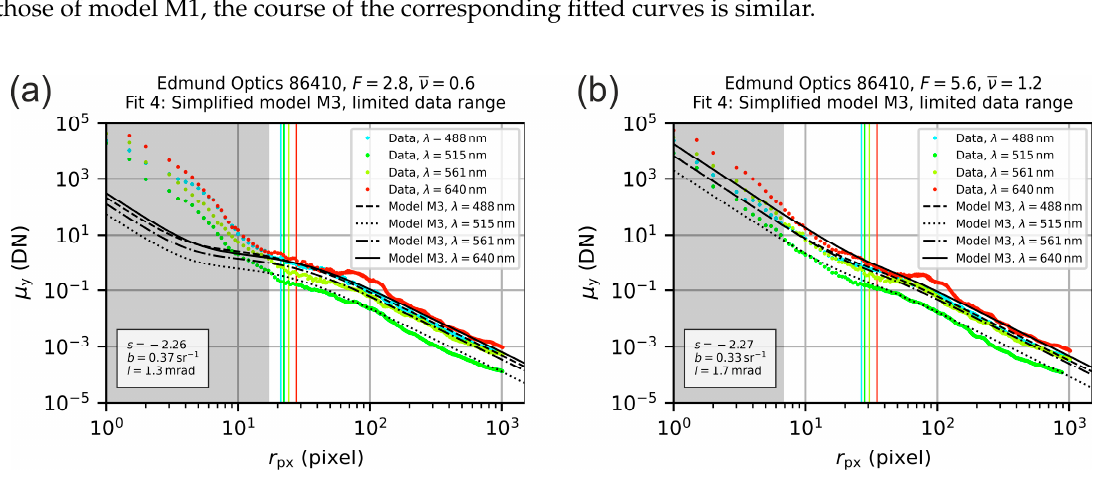
Figure 16. Radial irradiance distribution for the lens Edmund Optics 86410 operated with an f-number of ( a ) F = 2.8 and ( b ) F = 5.6. The colored points are the measured values derived from the analysis of the camera images. The black lines are the result of fitting the theoretical model M3 to the data within a limited range of the radial coordinate.